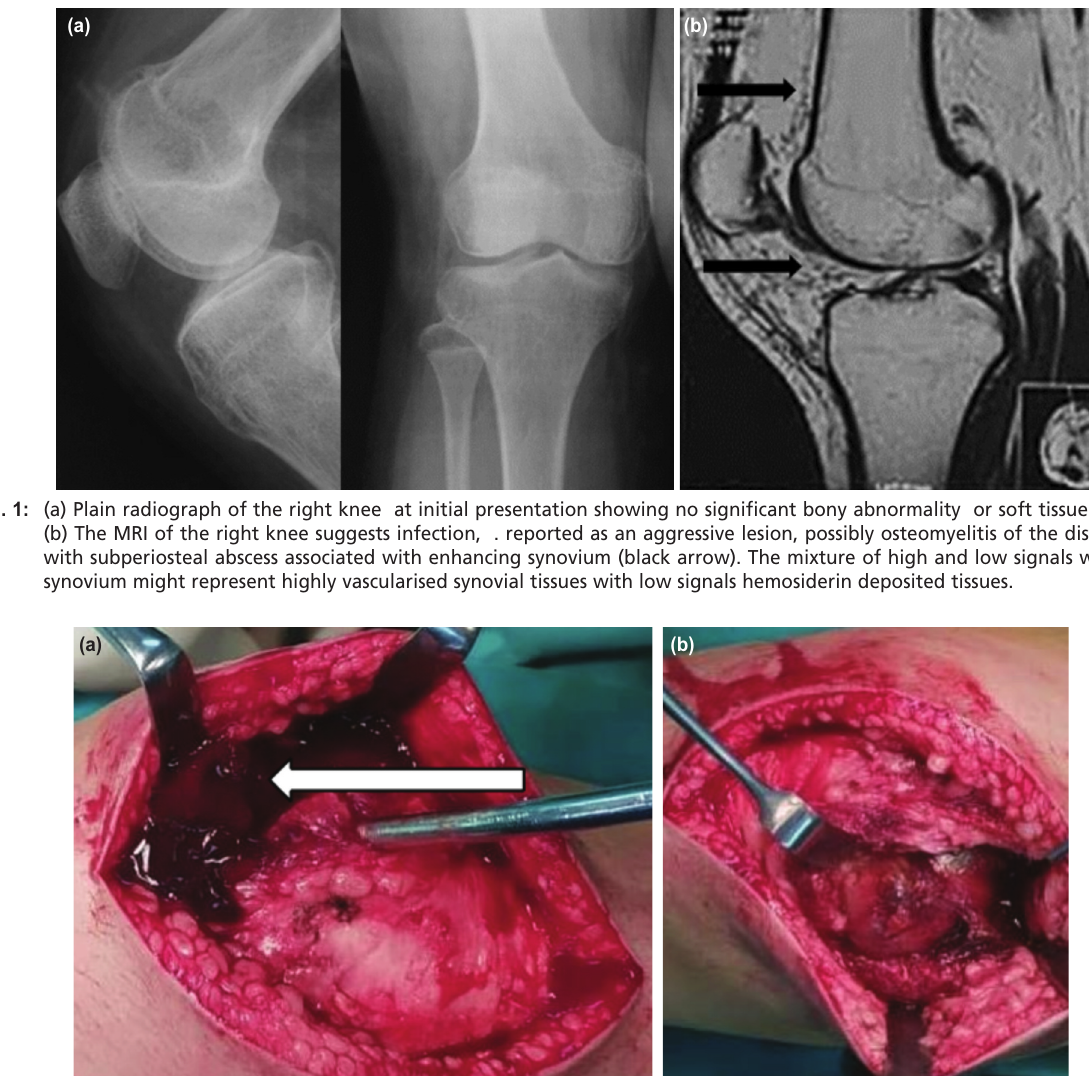
(a) and (b) Intra-operative photographs of right knee with white arrow showing haemarthrosis, and the synovium swollen and